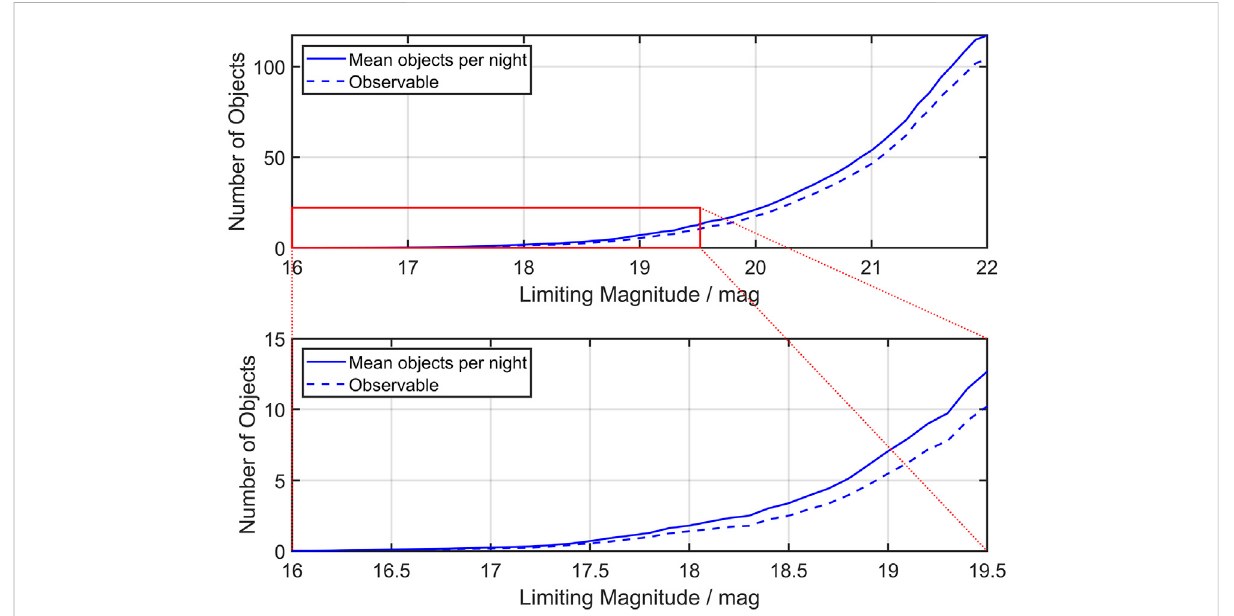
FIGURE 8 Results for the cumulative number of entries from the NEOCC Priority List from Figure 7 averaged per night with a magnitude brighter than a particular Limiting Magnitude and the observable of them (dashed). The range for the Limiting Magnitude from 16 to 22 mag is shown above, the extract of this up to 19.5 mag is shown below.